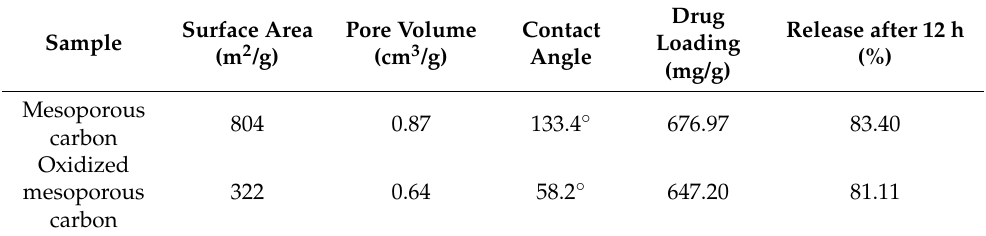
Table 9. The main characteristics of different carriers for